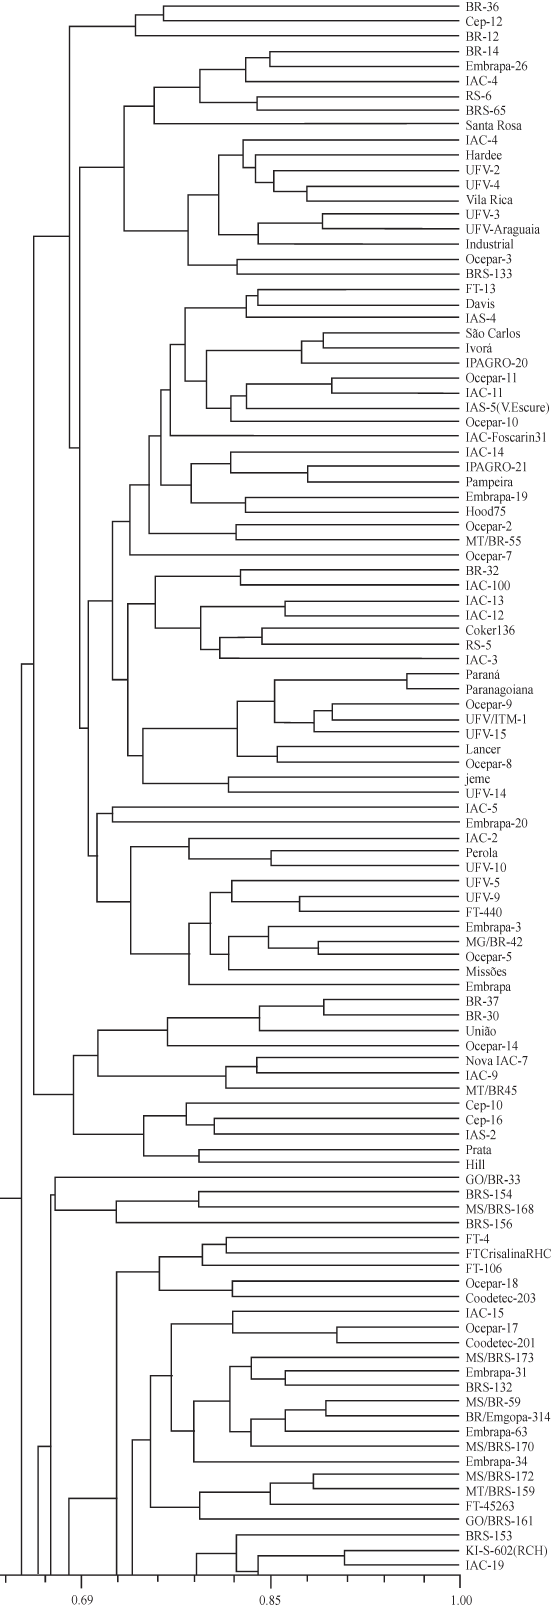
Figure 4a - UPGMA dendrogram based on AFLP similarity coefficients of 317 soybean